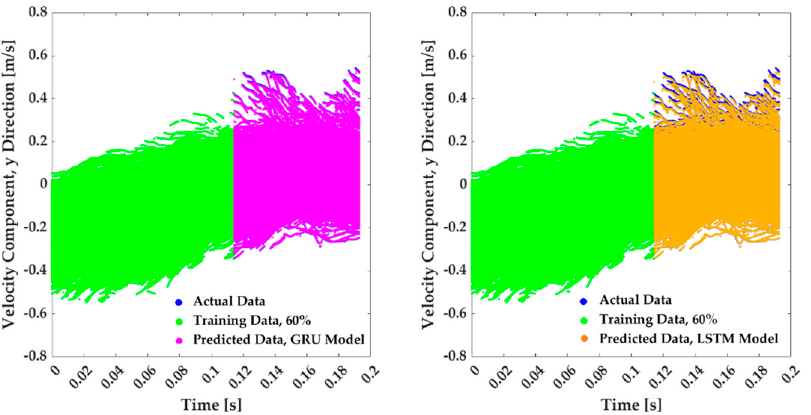
Figure 7. Prediction of velocity component in the y direction for a strained turbulent flow with mean strain rate 8 s − 1 , GRU model on the left ‐ hand side, and LSTM model on the right ‐ hand side. Training data are 80% and test data 20%.